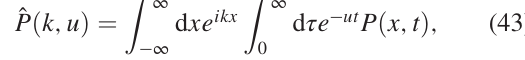
FIG. 5. Theconditionalprobability p ð χ j τ Þ isdescribedbytheAiry distribution when D → ∞ and otherwise by the distribution derived here based on the area under the Bessel process theory, Eq. (39). The distributions describe areas under constrained Brownian (or Bessel) excursions when the cooling force F ð p Þ ¼ 0 [or F ð p Þ ≠ 0